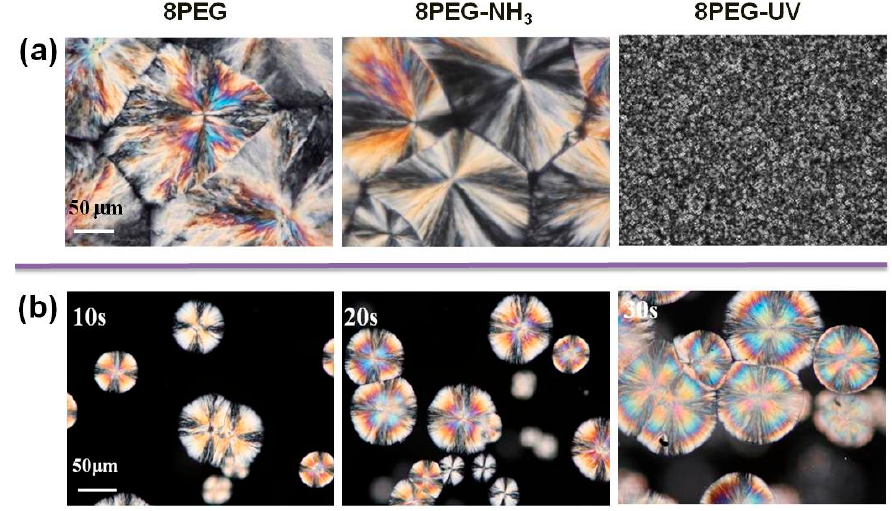
Figure 2. Polarized optical micrographs of ( a ) solid films of 8PEG macromonomer, 8PEG–NH 3